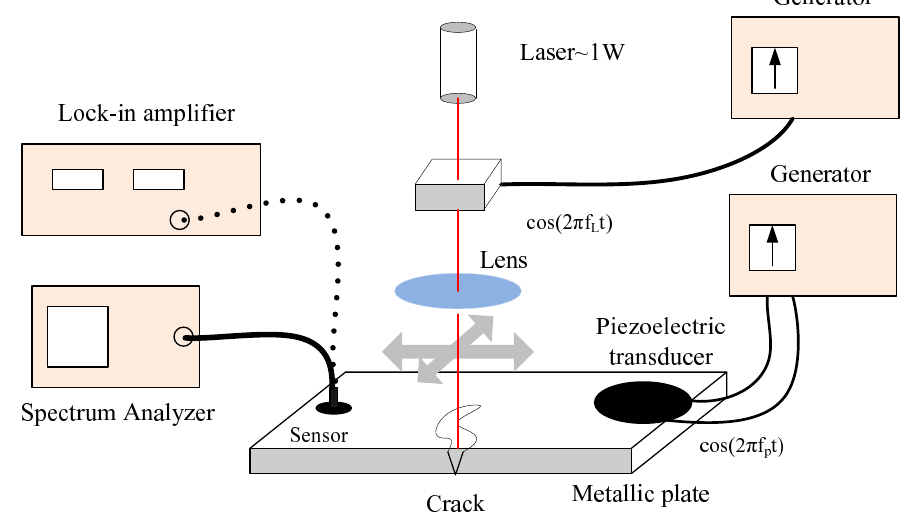
Figure 26. Experimental photoacoustic (PA)-acoustic imaging